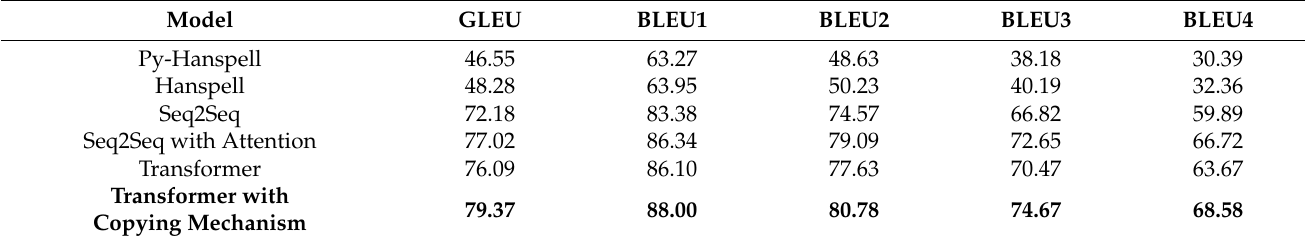
Table 9. Comparison of GEC Models (GLEU, BLEU).